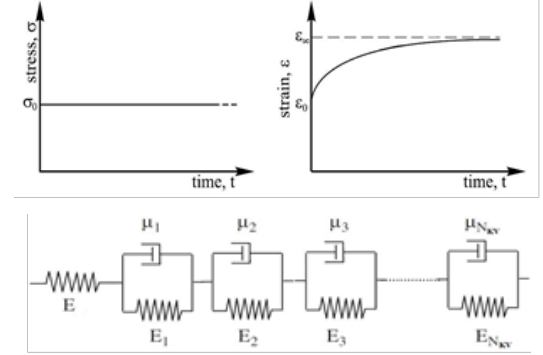
Fig 1. Top: creep test on a viscoelastic specimen; Bottom: generalized Kelvin-Voigt model (Brinson and Brinson